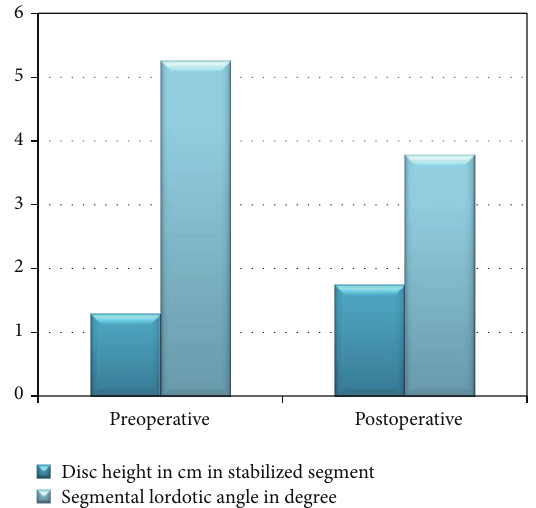
Figure 6: Comparative chart between preoperative and postopera- tive radiological